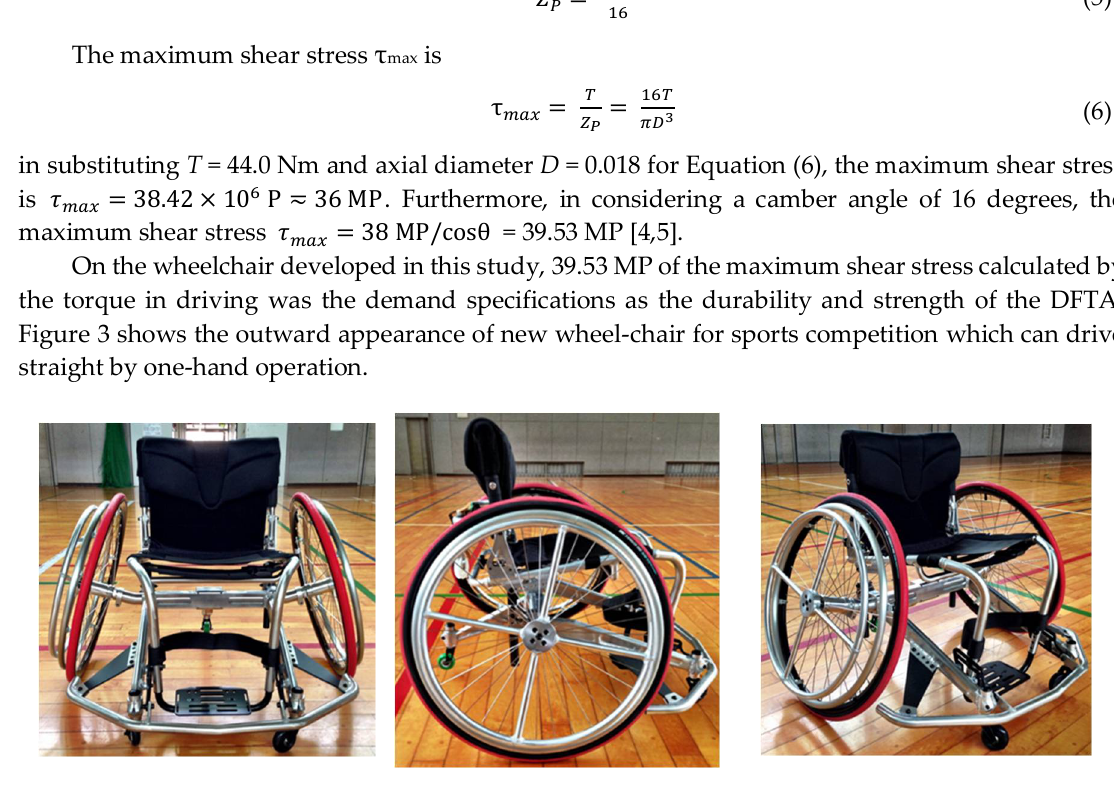
Figure 3. The outward appearance of new wheel-chair for sports competition which can drive straight by one-hand